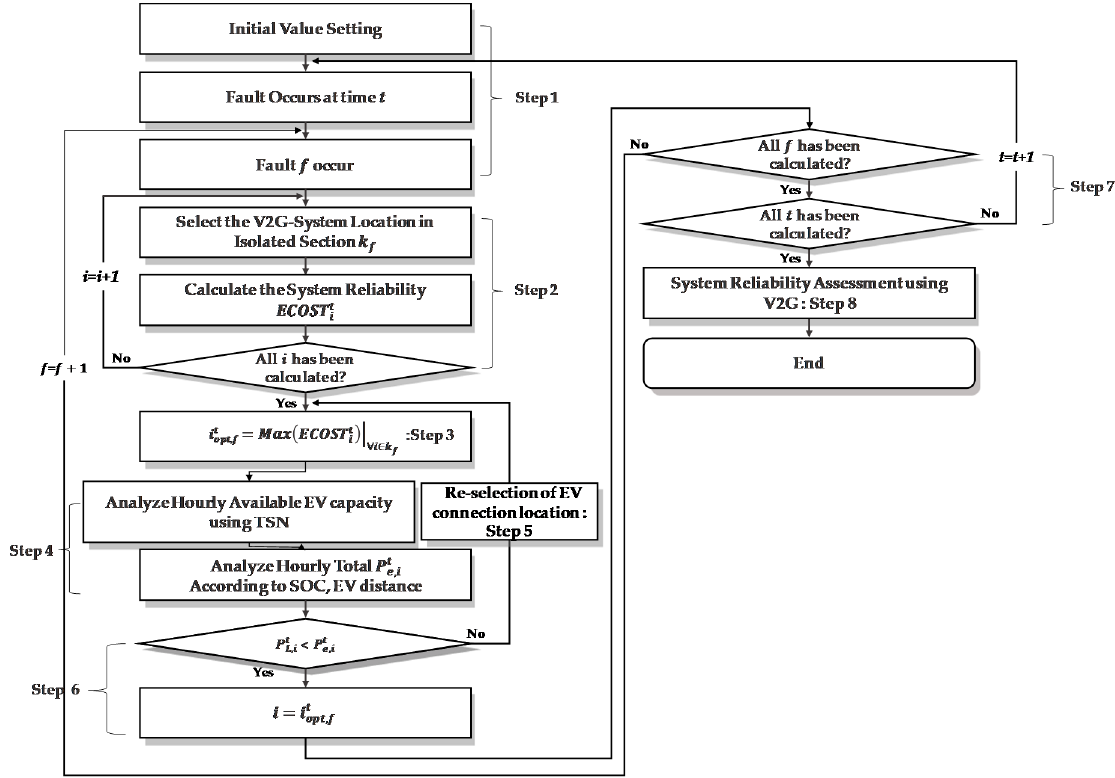
Figure 3. Flowchart of the optimization algorithm.